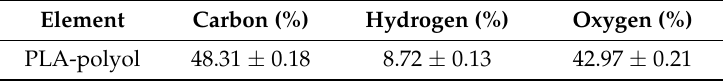
Table 3. Results of elemental analysis of PLA-polyol.